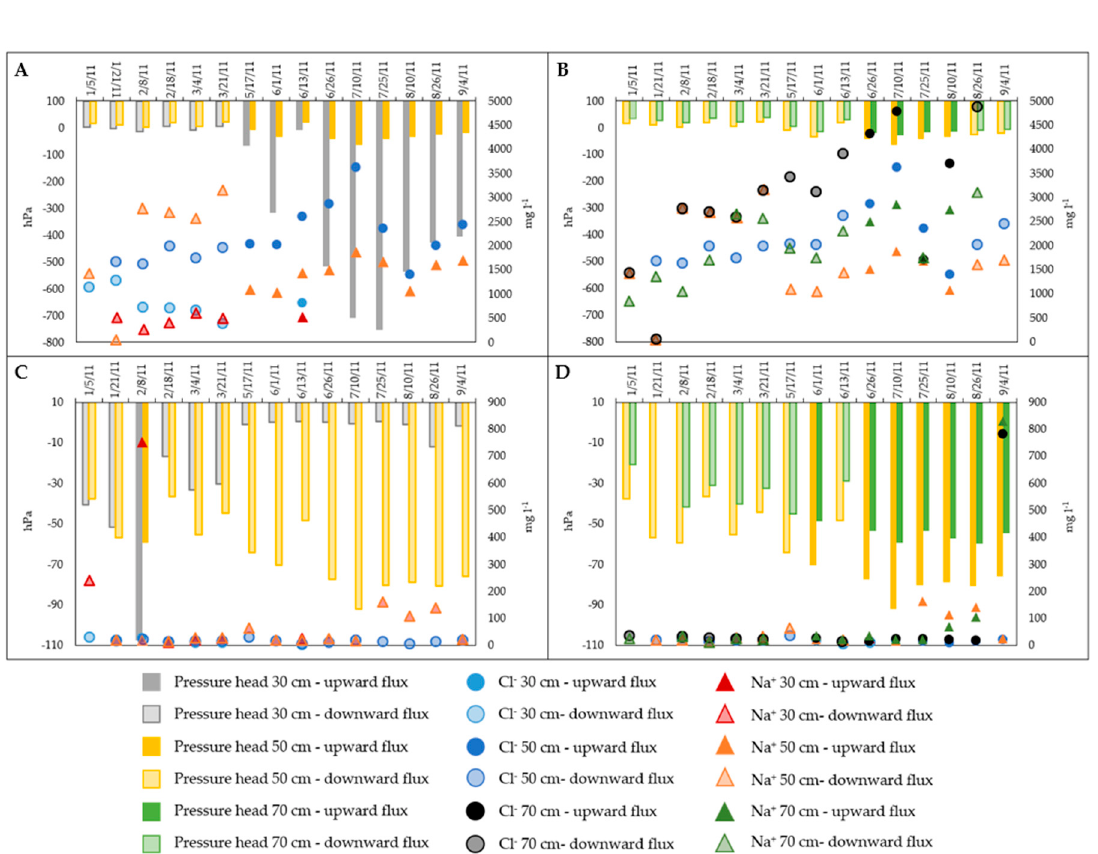
Figure 5. Pressure heads (hPa), Cl − and Na + (mg L − 1 ) concentrations observed at station C and B on different dates. ( A ) station C, 30–50 cm flux; ( B ) station C, 50–70 cm flux; ( C ) station B, 30–50 cm flux; ( D ) station B, 50–70 cm flux.